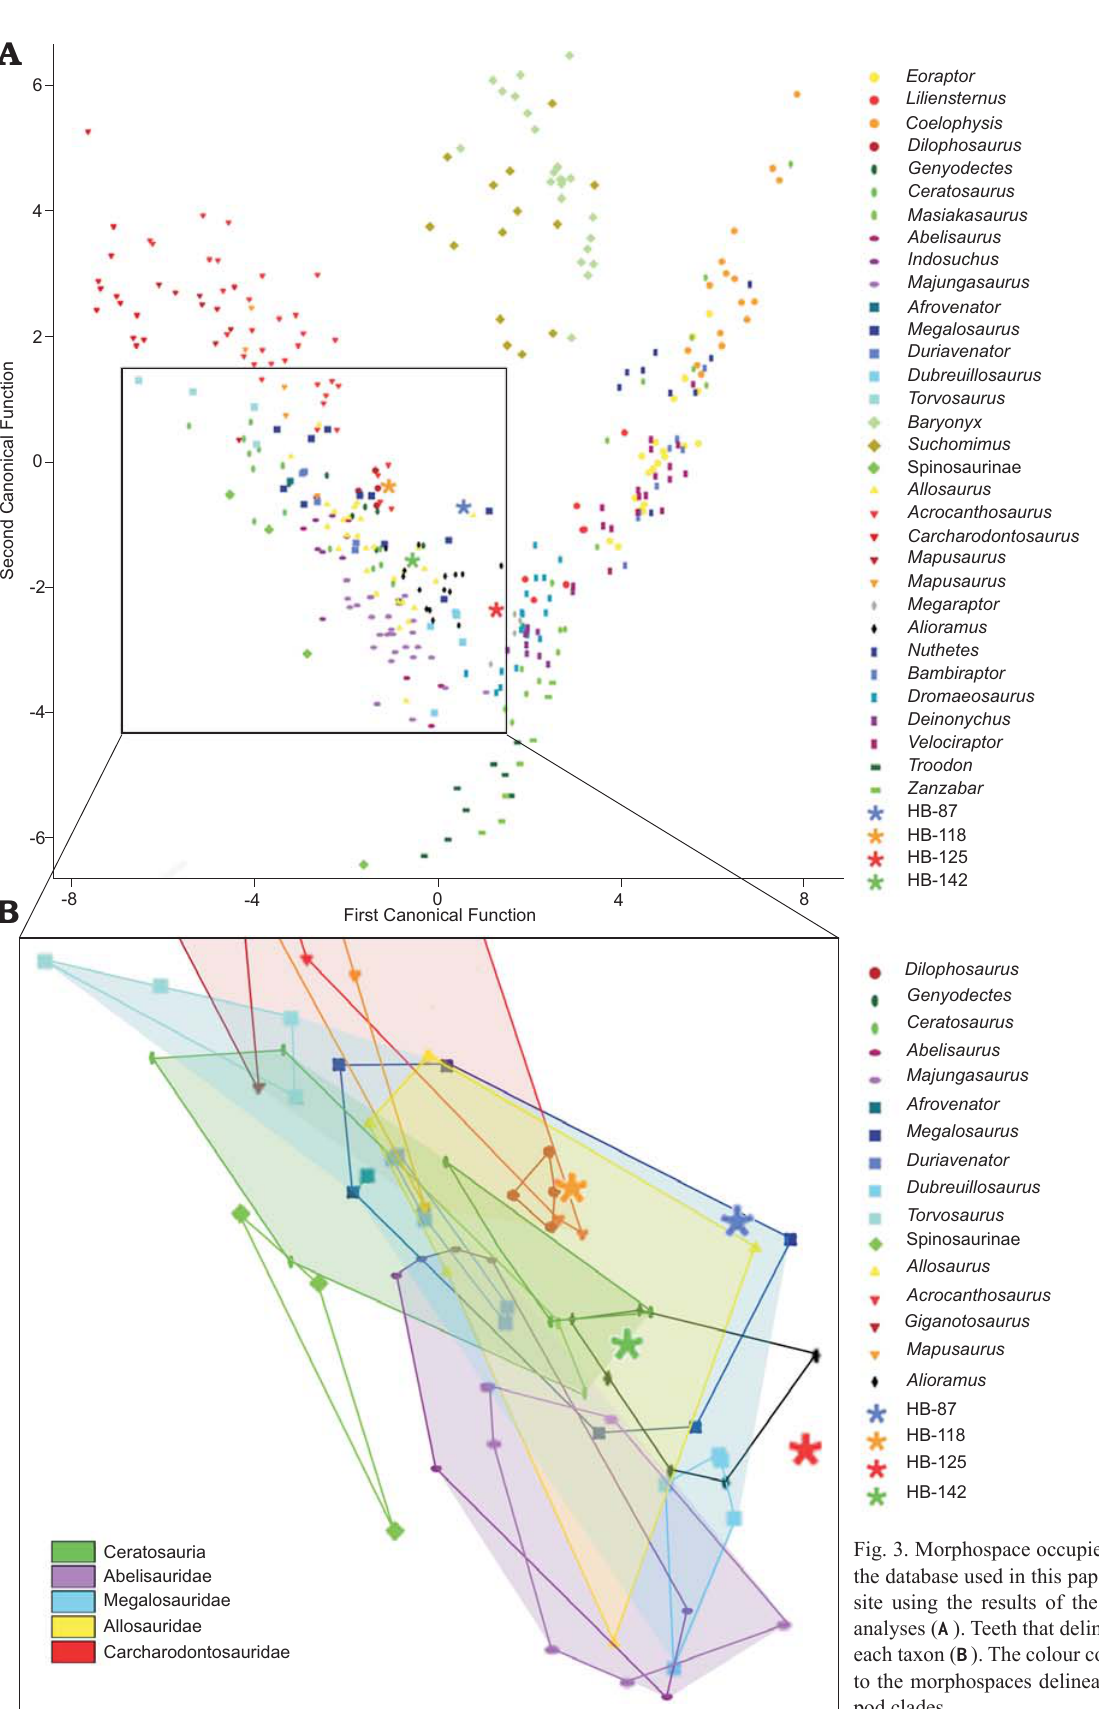
Fig. 3. Morphospace occupied by theropod teeth of the database used in this paper and those of the HB site using the results of the discriminant function analyses ( A ). Teeth that delimit the morphospace of each taxon ( B ). The colour convex hulls correspond to the morphospaces delineated by different thero- pod